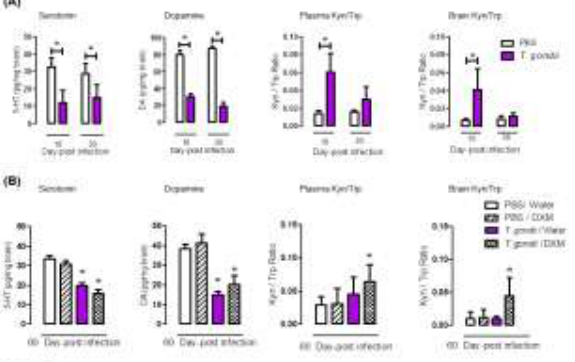
Fig. 5: Reduction of serotonin and dopamine levels, and enhanced tryptophan catabolism following T. gondii infection. (A) In T. gondii- infected or PBS-injected mice, brain serotonin, dopamine (DA) and Trp turnover to L-kynurenine (Kyn) /Trp ratio, and plasma Kyn/Trp ratio were determined at 10 and 30 days post-infection (dpi) ( n = 10). (B) Similarly these variables were measured before and after DXM treatment ( n =